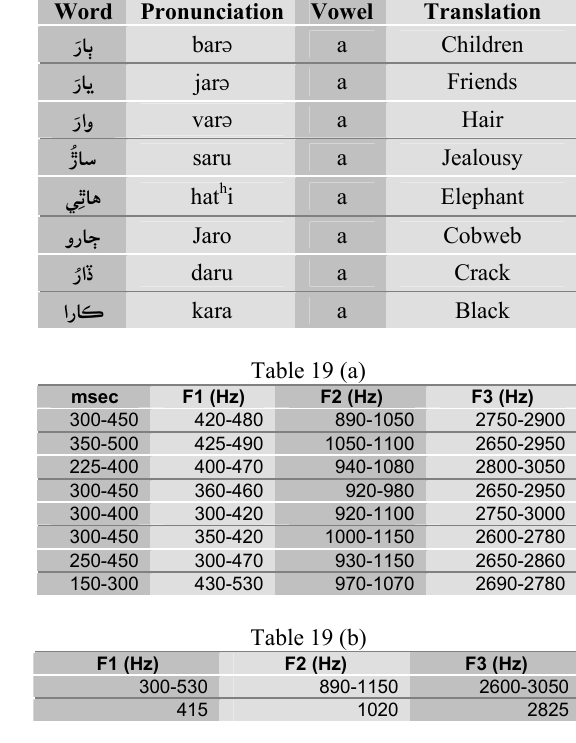
Fig 2: Spectrogram, LPC, and formant track for utterance “sar ə ”,